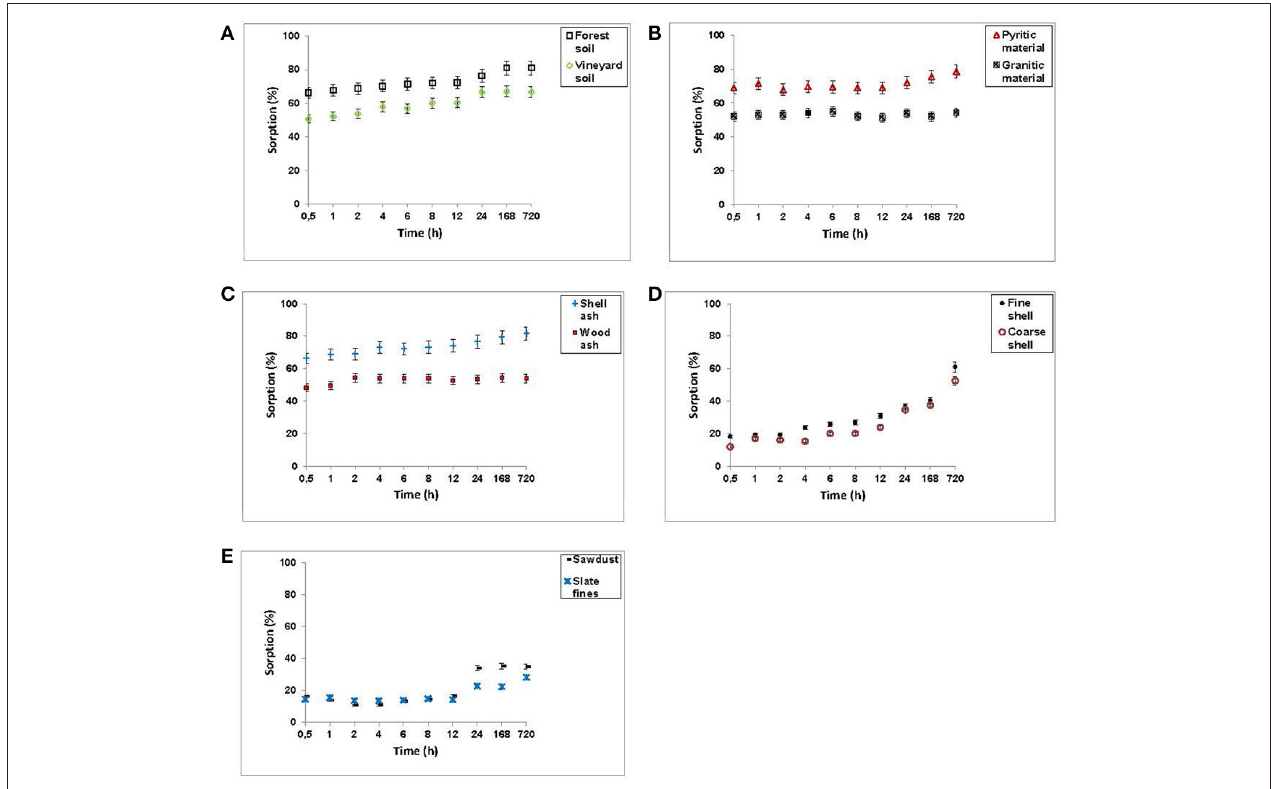
FIGURE 2 | Sorption results (expressed as %) for F − on the soils, by-products and waste materials studied, at different incubation times. Average values (three replicates), with coefficients of variation < 5%.